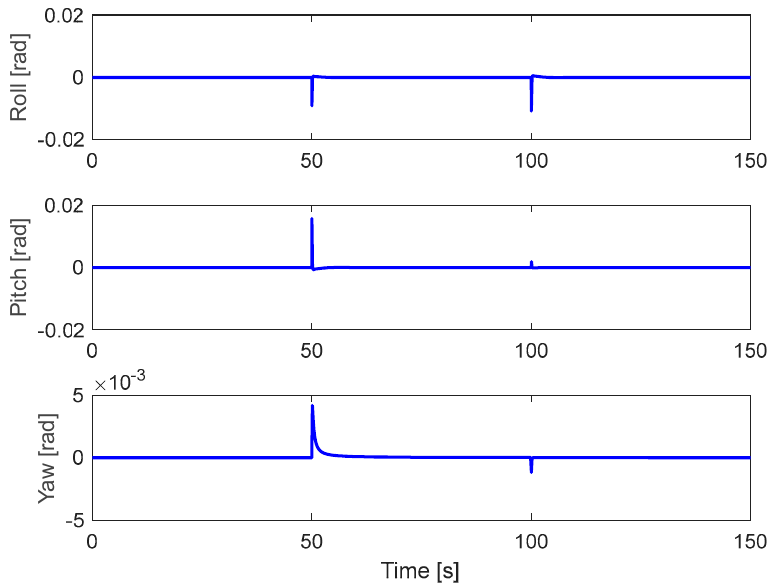
Figure 6. Attitude angle performance with complete fault in actuator 1 and partial fault in actuator 2.